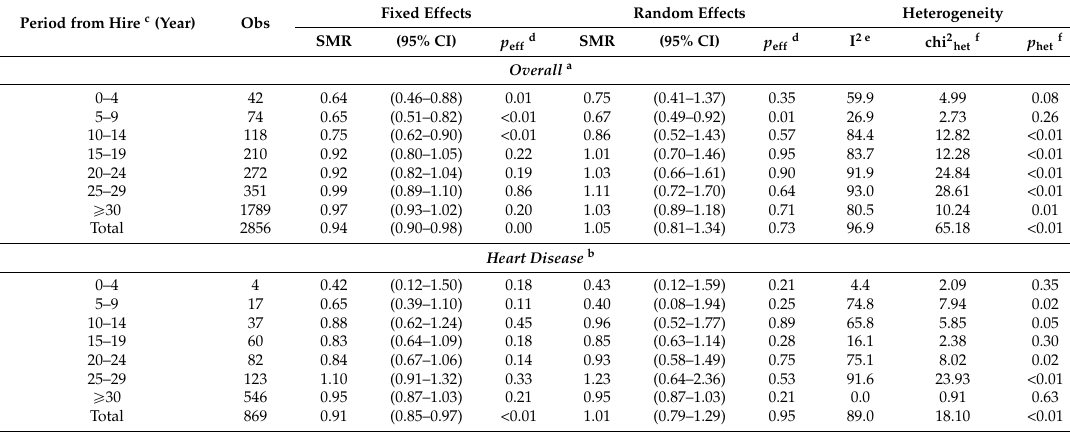
Table 2. Meta analyses of standardised mortality ratios (SMRs) for overall a and cardiac b mortality based on national rates by period from hire, in carbon black production workers of three full cohorts combined (US, UK,